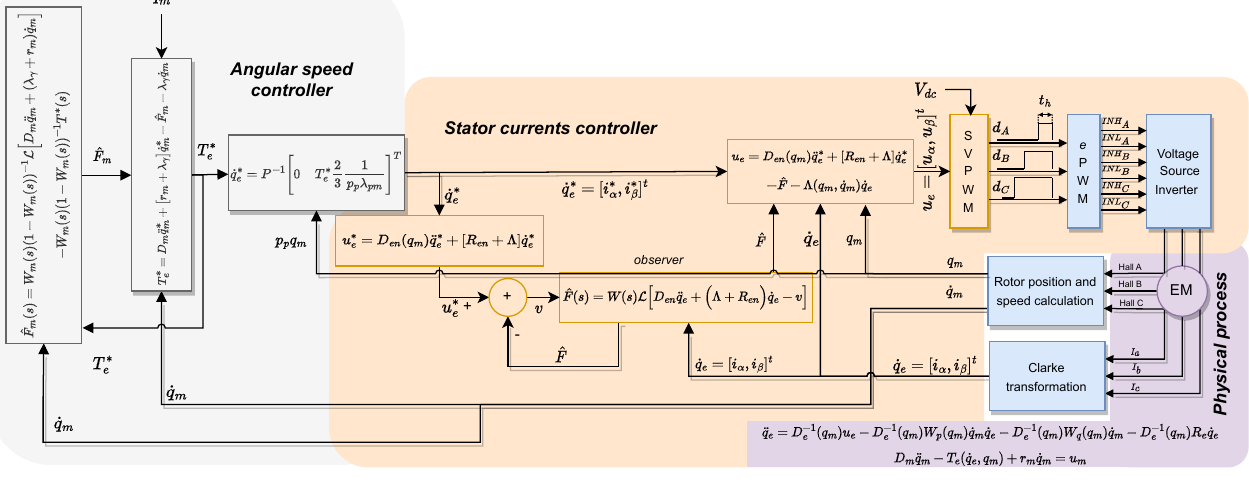
Figure 2. Illustration of the control